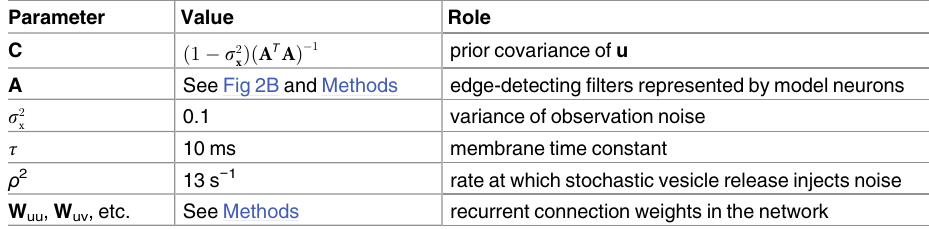
Table 1. Values of the parameters used in our simulations.